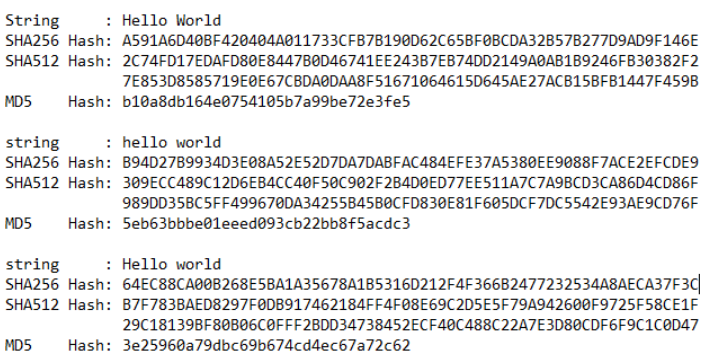
Figure 6. Hash values generated by different Hashing